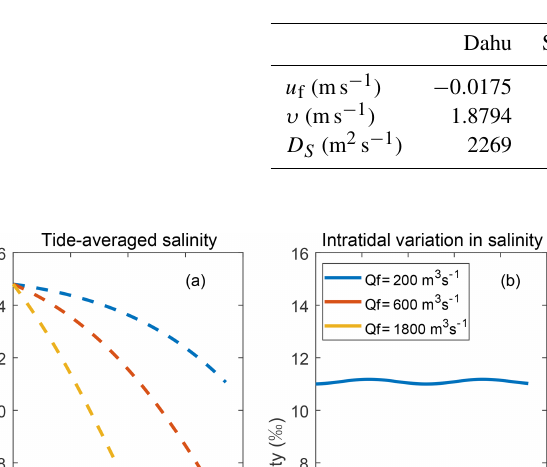
Table 4. Calibration results of Song’s model.